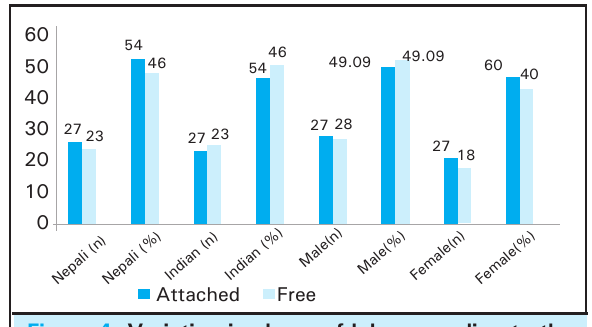
Figure 4. Variation in shape of lobe according to the nationality and gender (n=100).